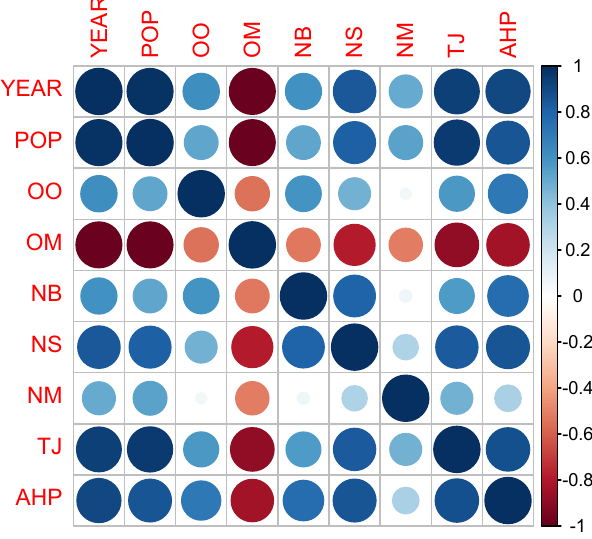
Figure 1. Correlation